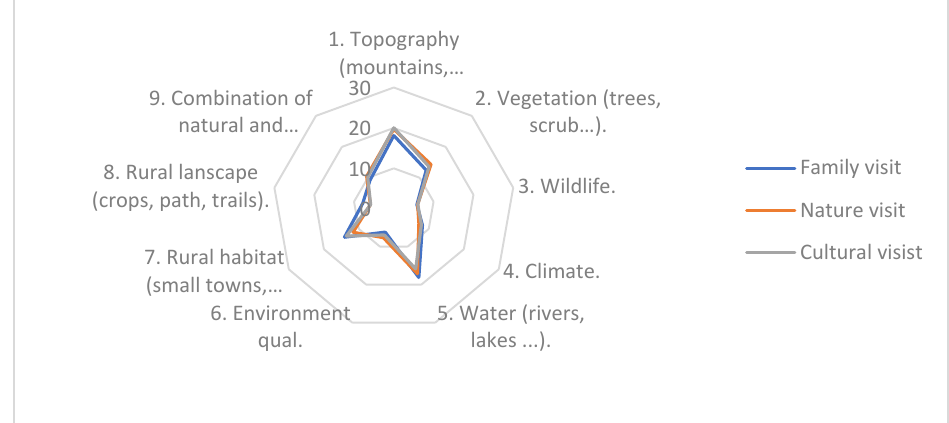
Figure 2. Elements that give personality to a landscape, according to the type of visit (% survey). (Source: Own preparation).